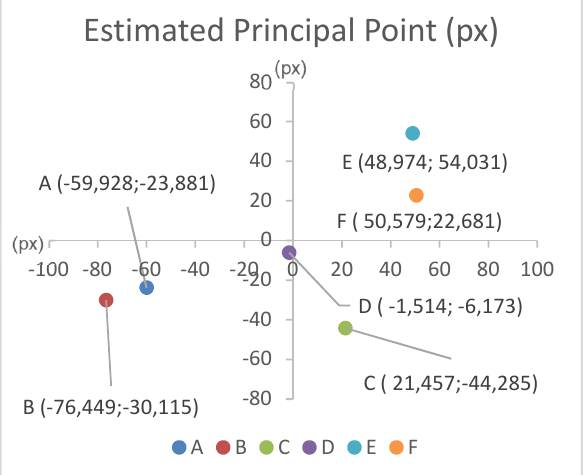
Figure 5. Estimated principal point coordinates of the six cameras separately considered and